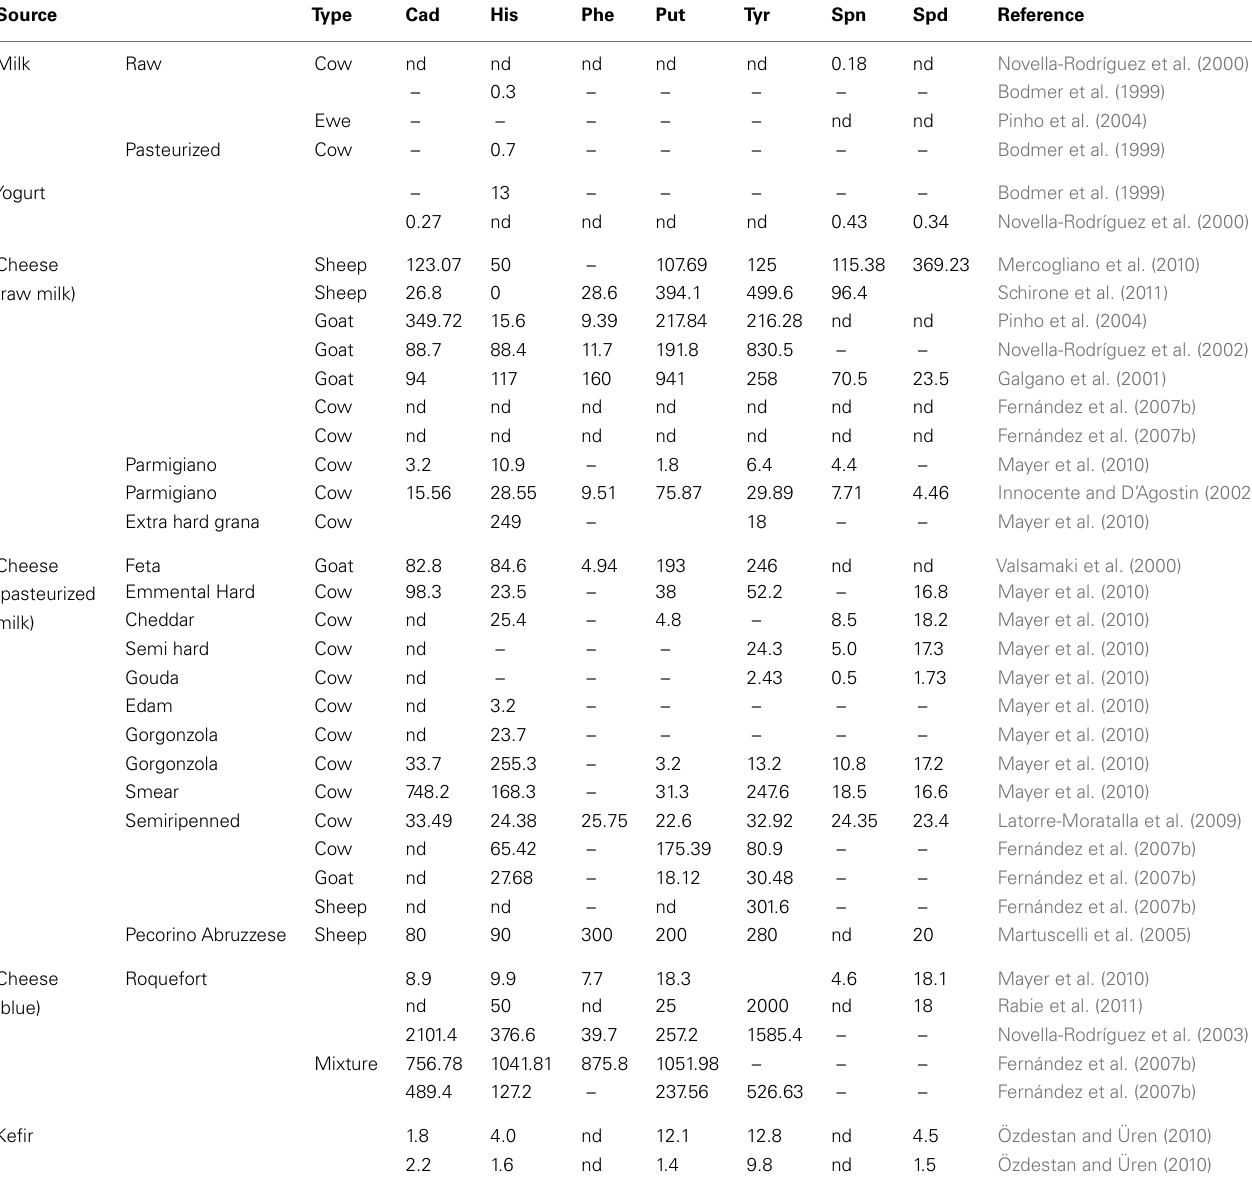
Table 1 | Biogenic amine content in dairy products